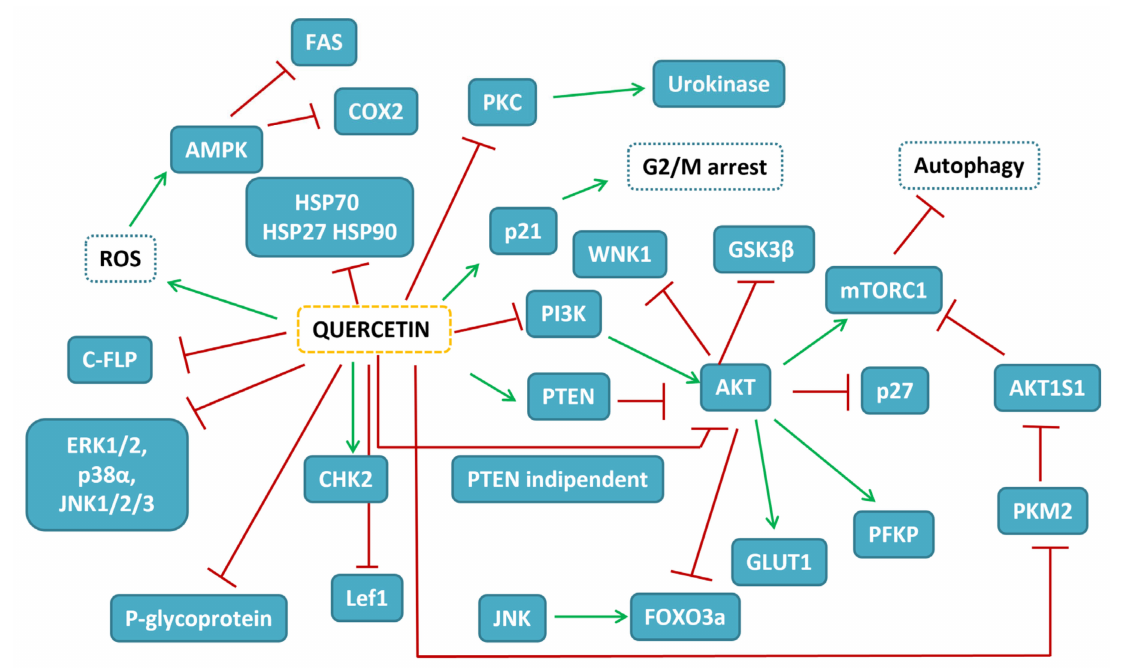
Figure 1. Map of the interactions of quercetin in BC experimental models. In blue-filled boxes, the protein influenced by quercetin treatment are reported, while blue-dashed boxes indicate cellular events. Red T-shaped lines correspond to inhibition, while green arrows to